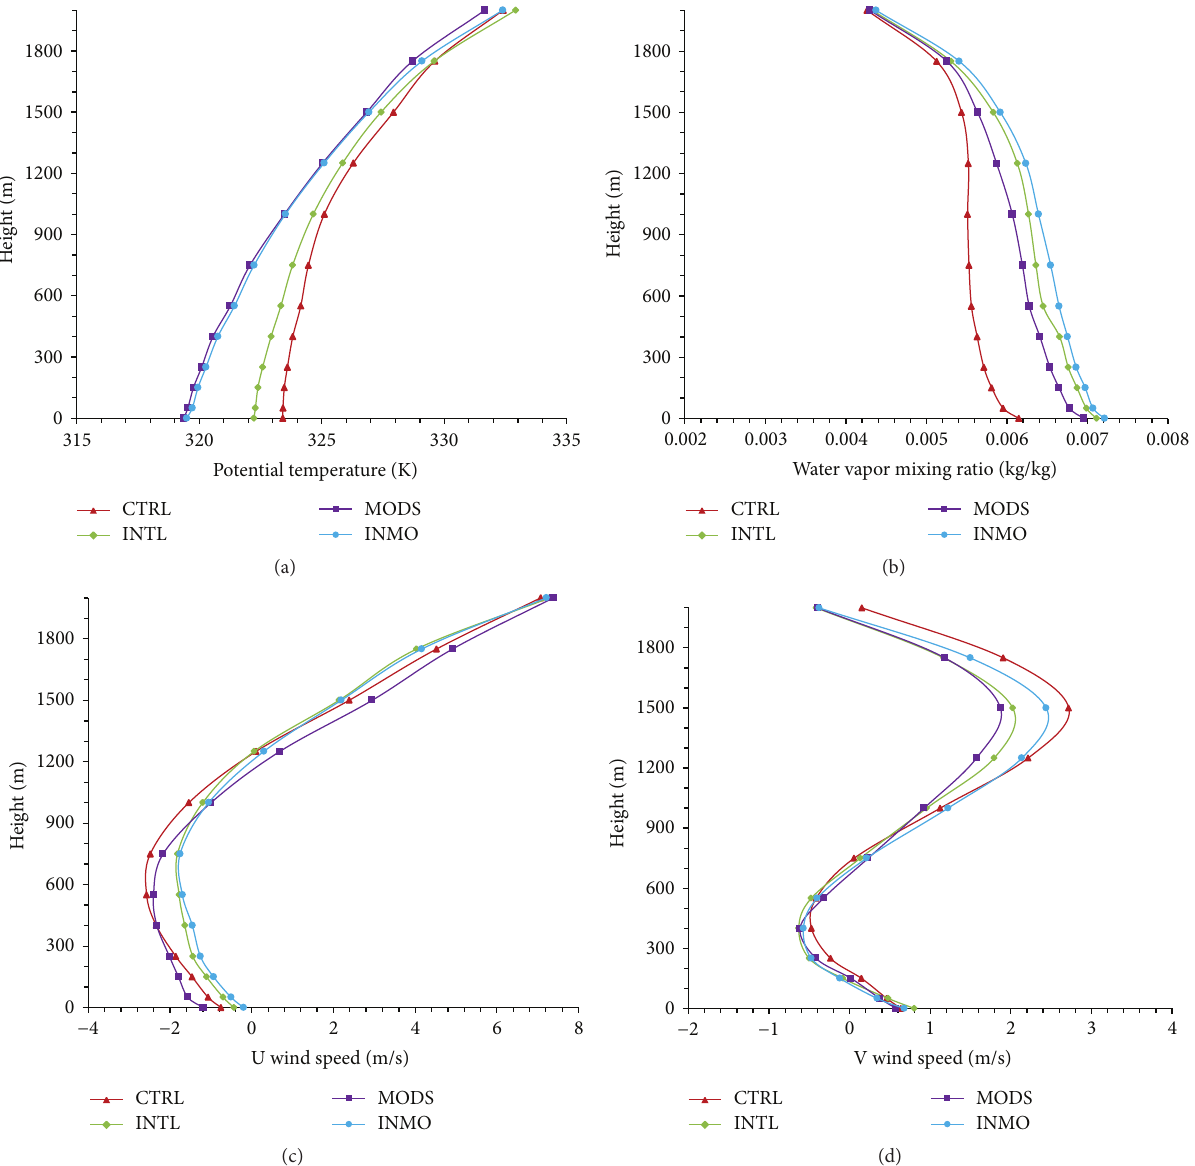
Figure 12: Average vertical profile of the boundary layer at Arou station in June at 12:00: (a) potential temperature, (b) water vapor mixing ratio, (c) U wind speed, and (d) V wind